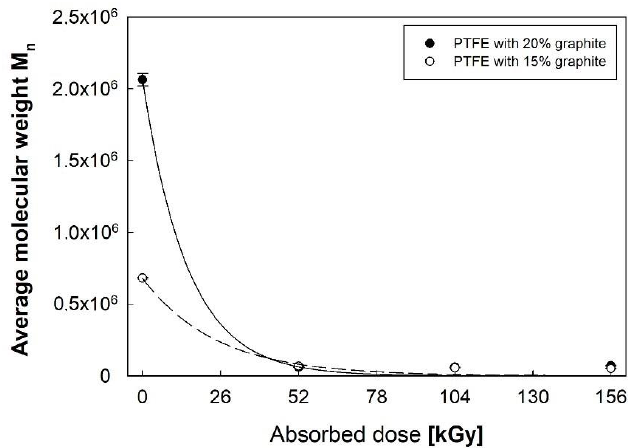
ff erent graphite additions.